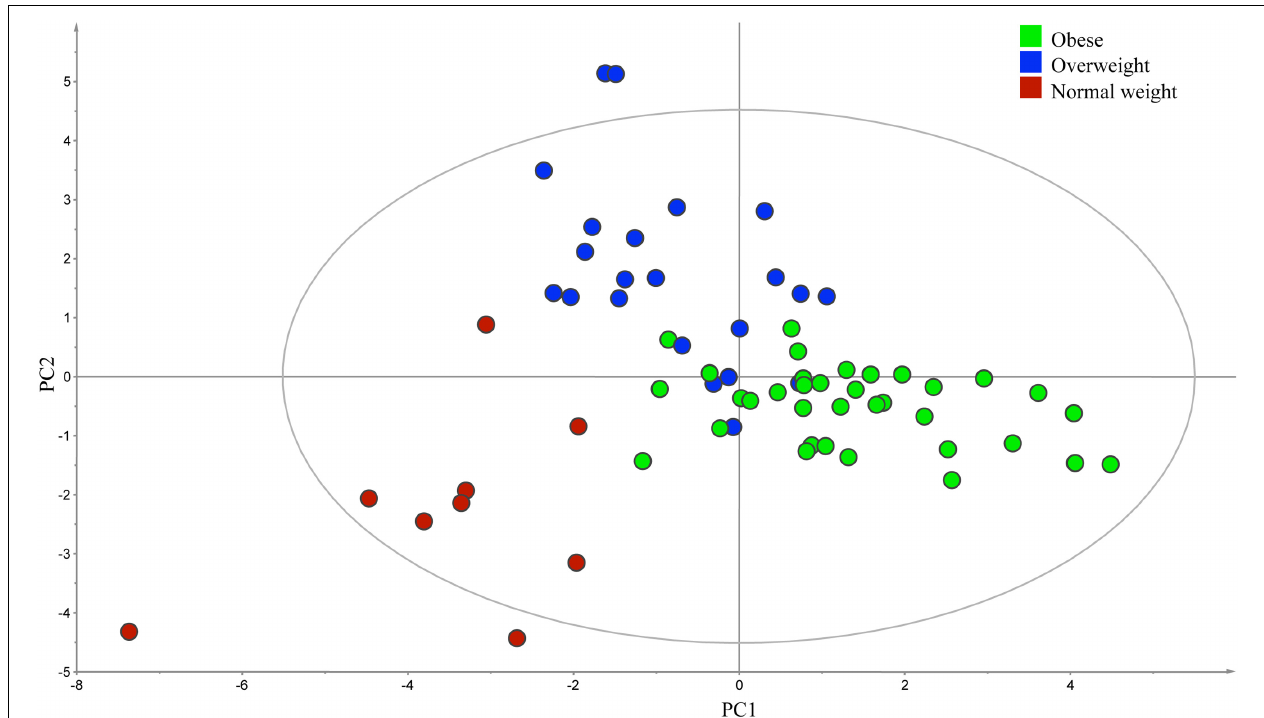
FIGURE 4 | Partial least square discriminant analysis score scatter plot of the gut microbiota comparing subjects with different body mass index (BMI). The distribution of fecal samples ( n = 66) indicated a significant difference in the composition of bacterial genera among obese (BMI > 30), overweight (BMI between 25 and 30), and normal weight (BMI < 25) groups. The R 2 ( = 0.60) and Q 2 ( = 0.32) estimates were calculated based on three